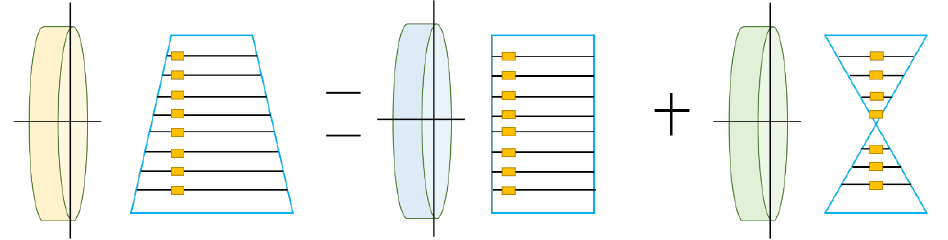
Figure 2. Equivalent force model of end-reinforced soil.